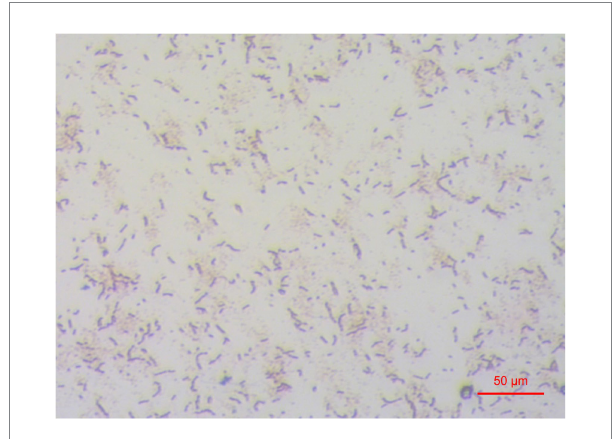
FIGURE 1 Gram-staining of strain Z129 observed by a bright-field